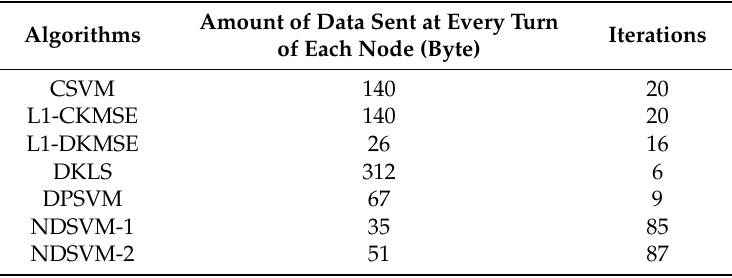
Table 3. Communication costs of the algorithms for the synthetic